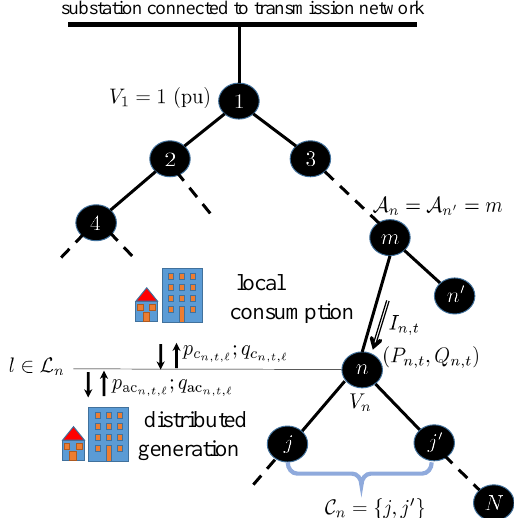
Figure 1. A radial distribution network with users at each node.